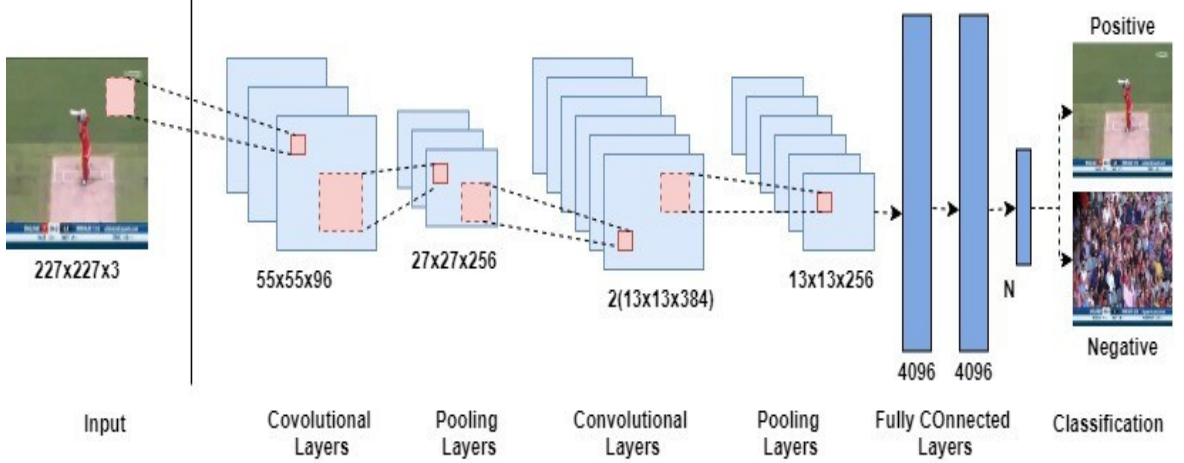
Figure 8. The architecture of AlexNet for the proposed method.